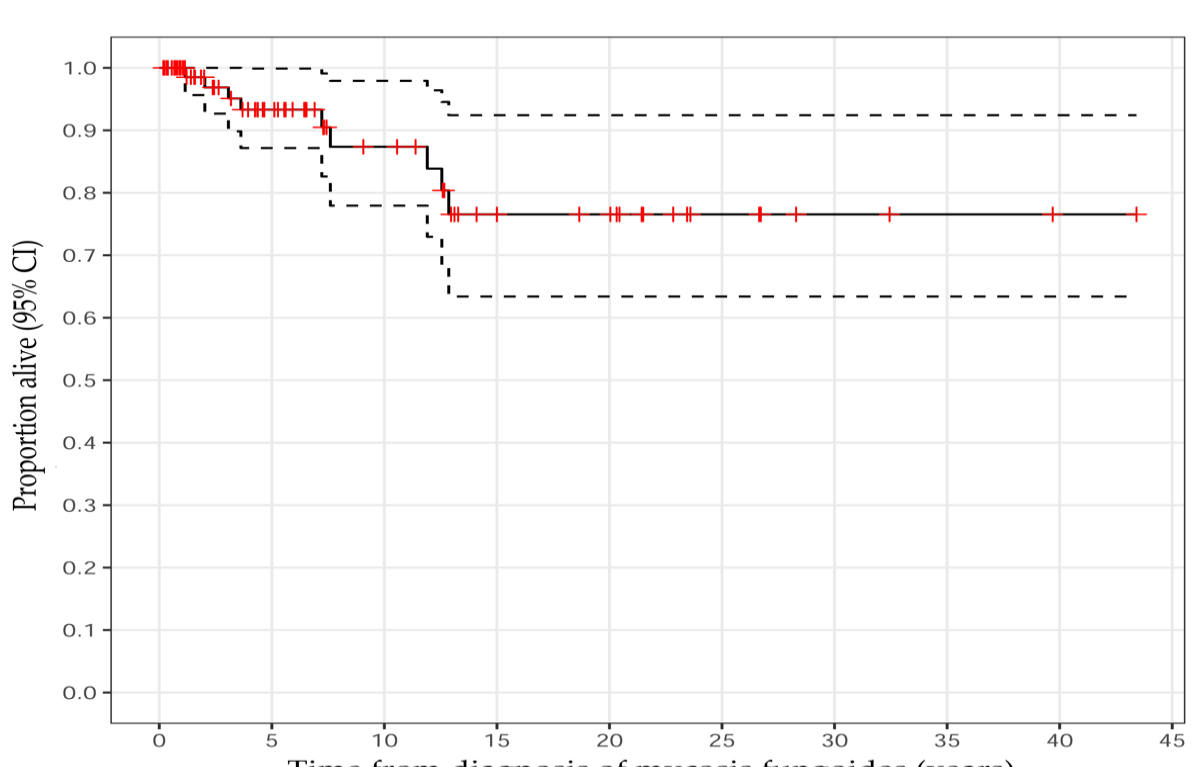
Figure 4. Kaplan – Meier survival plot for all patients with mycosis fungoides. The dotted lines are 95% confidence intervals (CI). The small vertical lines in red denote patients lost to follow-up.